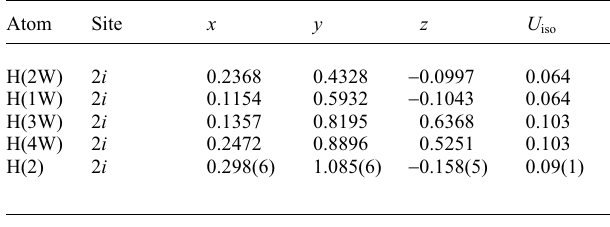
Table 3. Atomic coordinates and displacement parameters (in Å 2 ) .